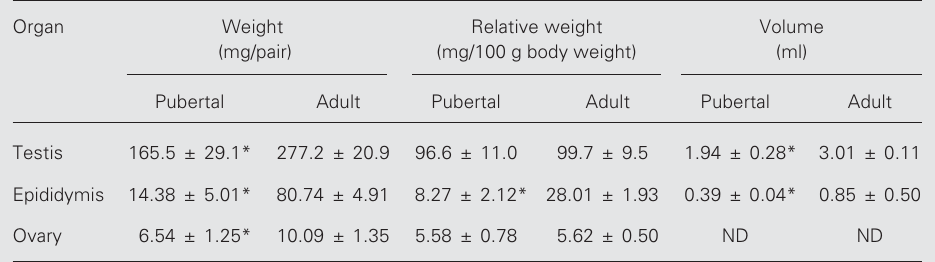
Table 1. Comparison of the reproductive organs of pubertal (50-55 days old) and adult control (90-95 days old) Fisher rats.